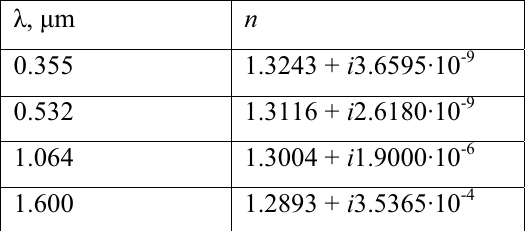
on (cid:3) for the solid max